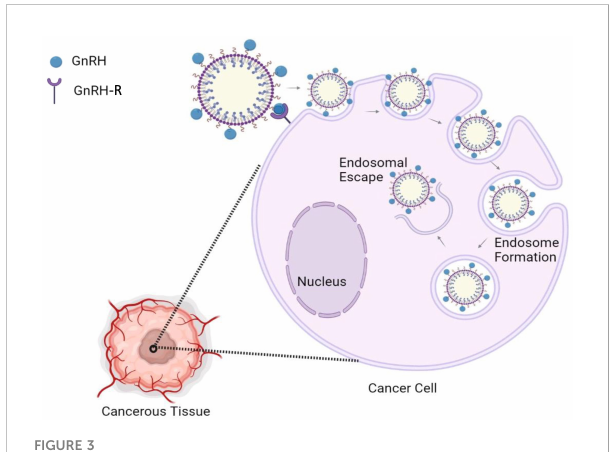
FIGURE 3 Input mechanism of GnRH-based nanoparticles for cancer cells. Nanoparticles coated with GnRH interact with the GnRH-R, promoting the entrance into cancer cells via endosome formation. Then, the nanoparticle content is released inside the cell.